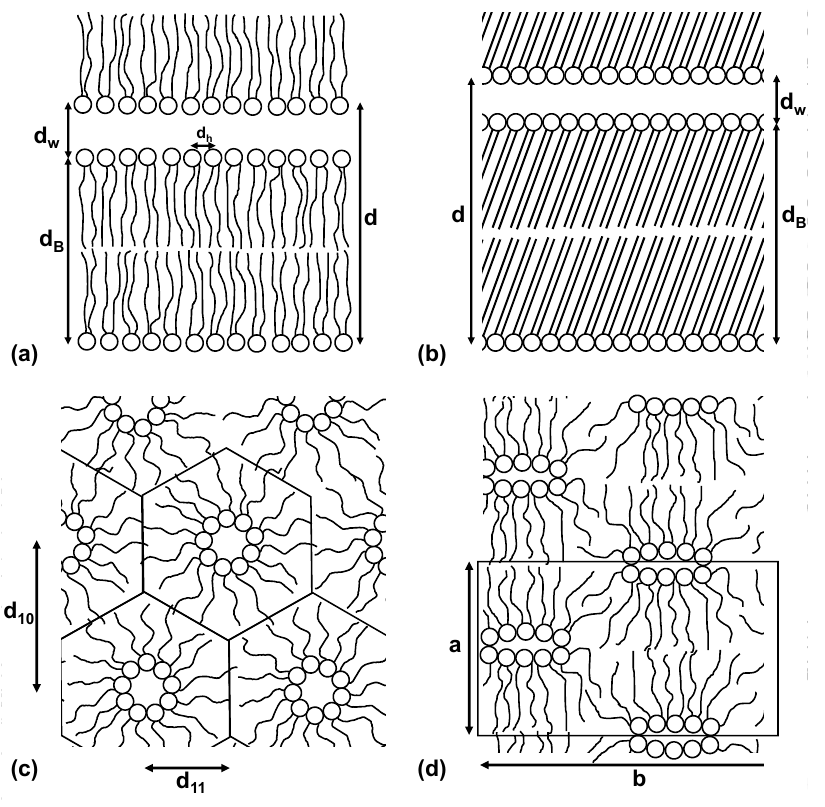
Figure 1. The lipid phases involved in freezing or desiccation-induced cellular damage: ( a ) the fluid lamellar phase consists of alternating layers of lipid bilayers (thickness, d ) B ) and separation between head groups, d . In the fluid lamellar and water (thickness, d w h phase, the tail chains are packed rather randomly in the hydrophobic phase; ( b ) the gel phase is very similar in geometry, with the difference being a closer packing of head groups and extended frozen lipid chains; ( c ) the hexagonal phase causes loss of bilayer structure and is characterized by a hexagonal symmetry with two characteristic repeat distances. Each hexagon has at its center a circular channel of water projecting out of the page surface; ( d ) the ribbon phase, where the unit cell is again characterized by two characterized by repeat distances. A ribbon-like channel formed by lipid head groups projects out of the